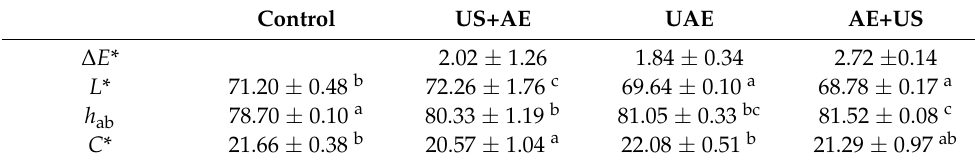
Table 5. Color properties of pumpkin seed protein